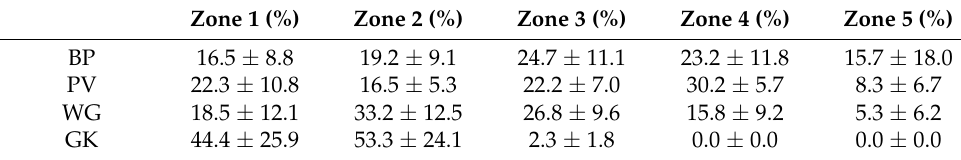
Table 5. Percentage of effective playing time spent in the different HR zones. Zone 1 (%) Zone 2 (%) Zone 3 (%) Zone 4